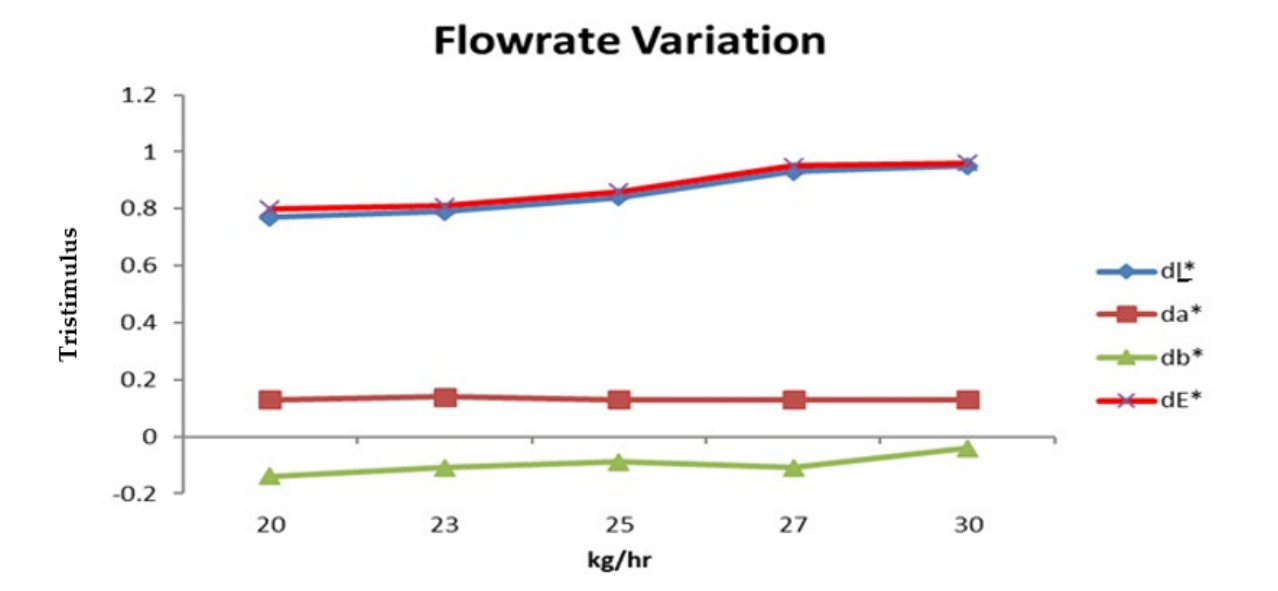
Figure 9. Tristimulus versus feed rate on grade 3.